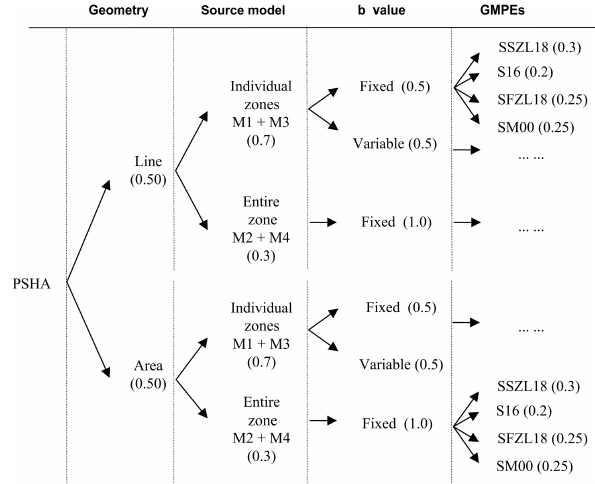
Figure 8. Logic tree structure with weightages for